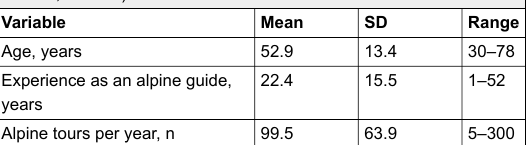
Table 1: Baseline characteristics of 62 alpine guides (n = 62; 7 women, 55 men). Variable